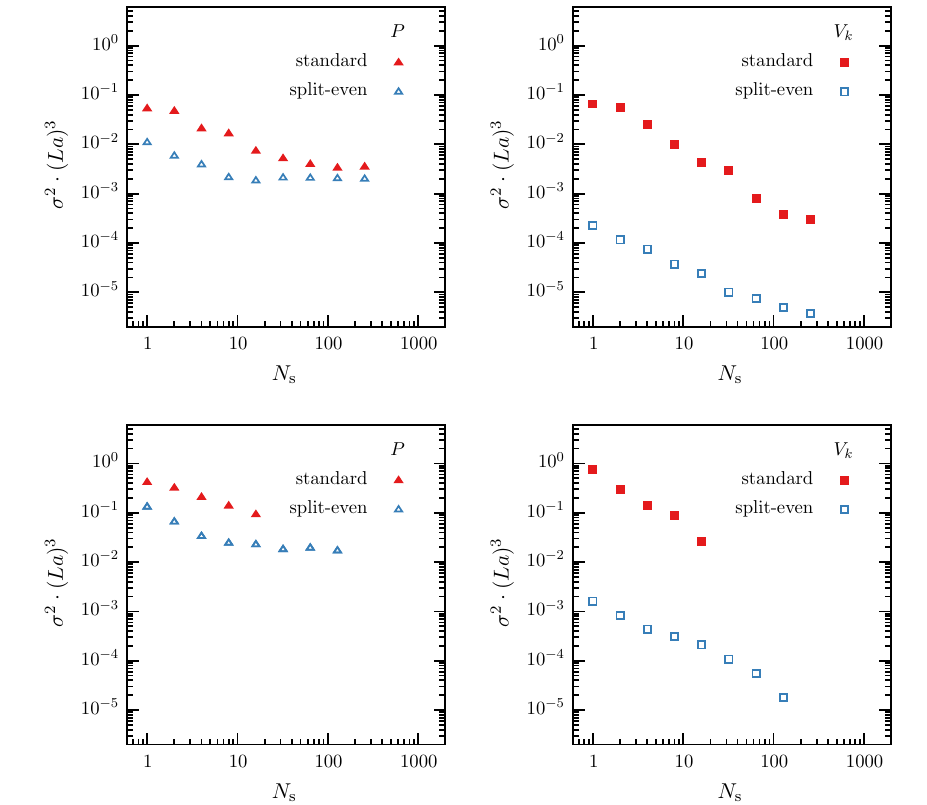
Fig. 9 The figures analogous to Fig. 4 comparing the variances of the standard (red) and split-even (blue) estimators in the pseudoscalar (left) and vector (right) channels for ensembles E5 (top) and G8